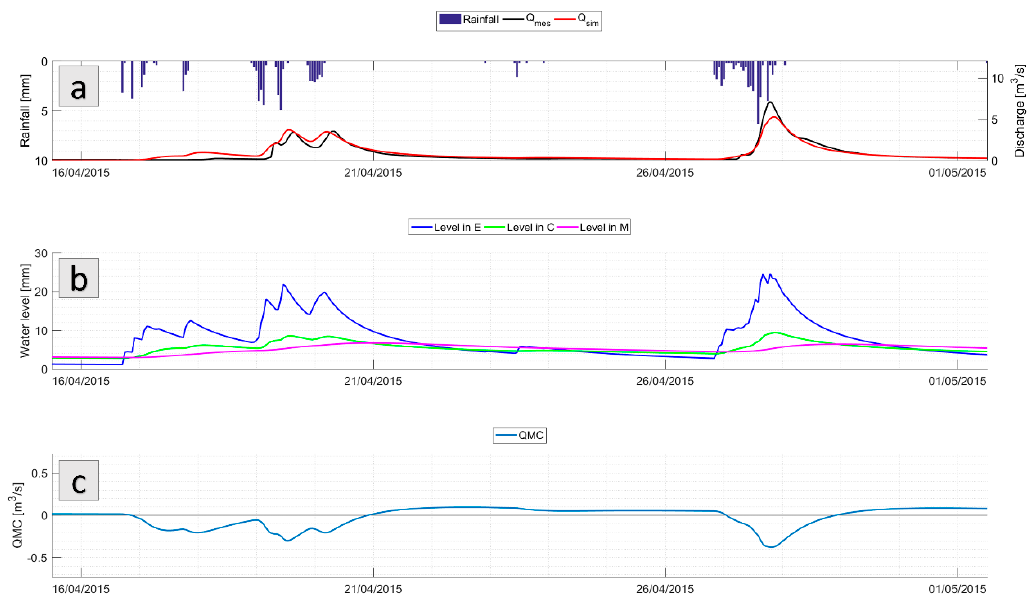
Figure 3. Example of event base time series for KarstMod model on Aliou watershed on the hourly sampling rate: ( a ) Rainfall time series with observed and simulated discharge; ( b ) water level in KarstMod reservoirs E, M and C and ( c ) fluxes between reservoir M and C. When Q MC > 0, the flow goes from reservoir M to C, otherwise the flow goes from reservoir C to M.